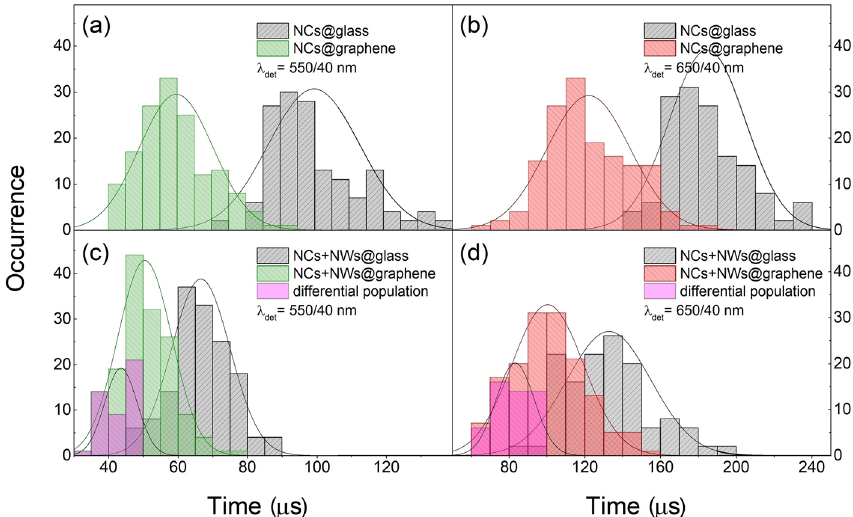
Figure 6. Histograms of luminescence decay times, acquired for: ( a , b ) nanocrystals and ( c , d ) nanocrystals coupled with silver nanowires, deposited on glass and graphene. Pink bars denote residual population of NCs coupled to graphene and silver NWs. Each distribution contains about 150 experimental points. Decay times reflect intensity-weighted average lifetimes 26